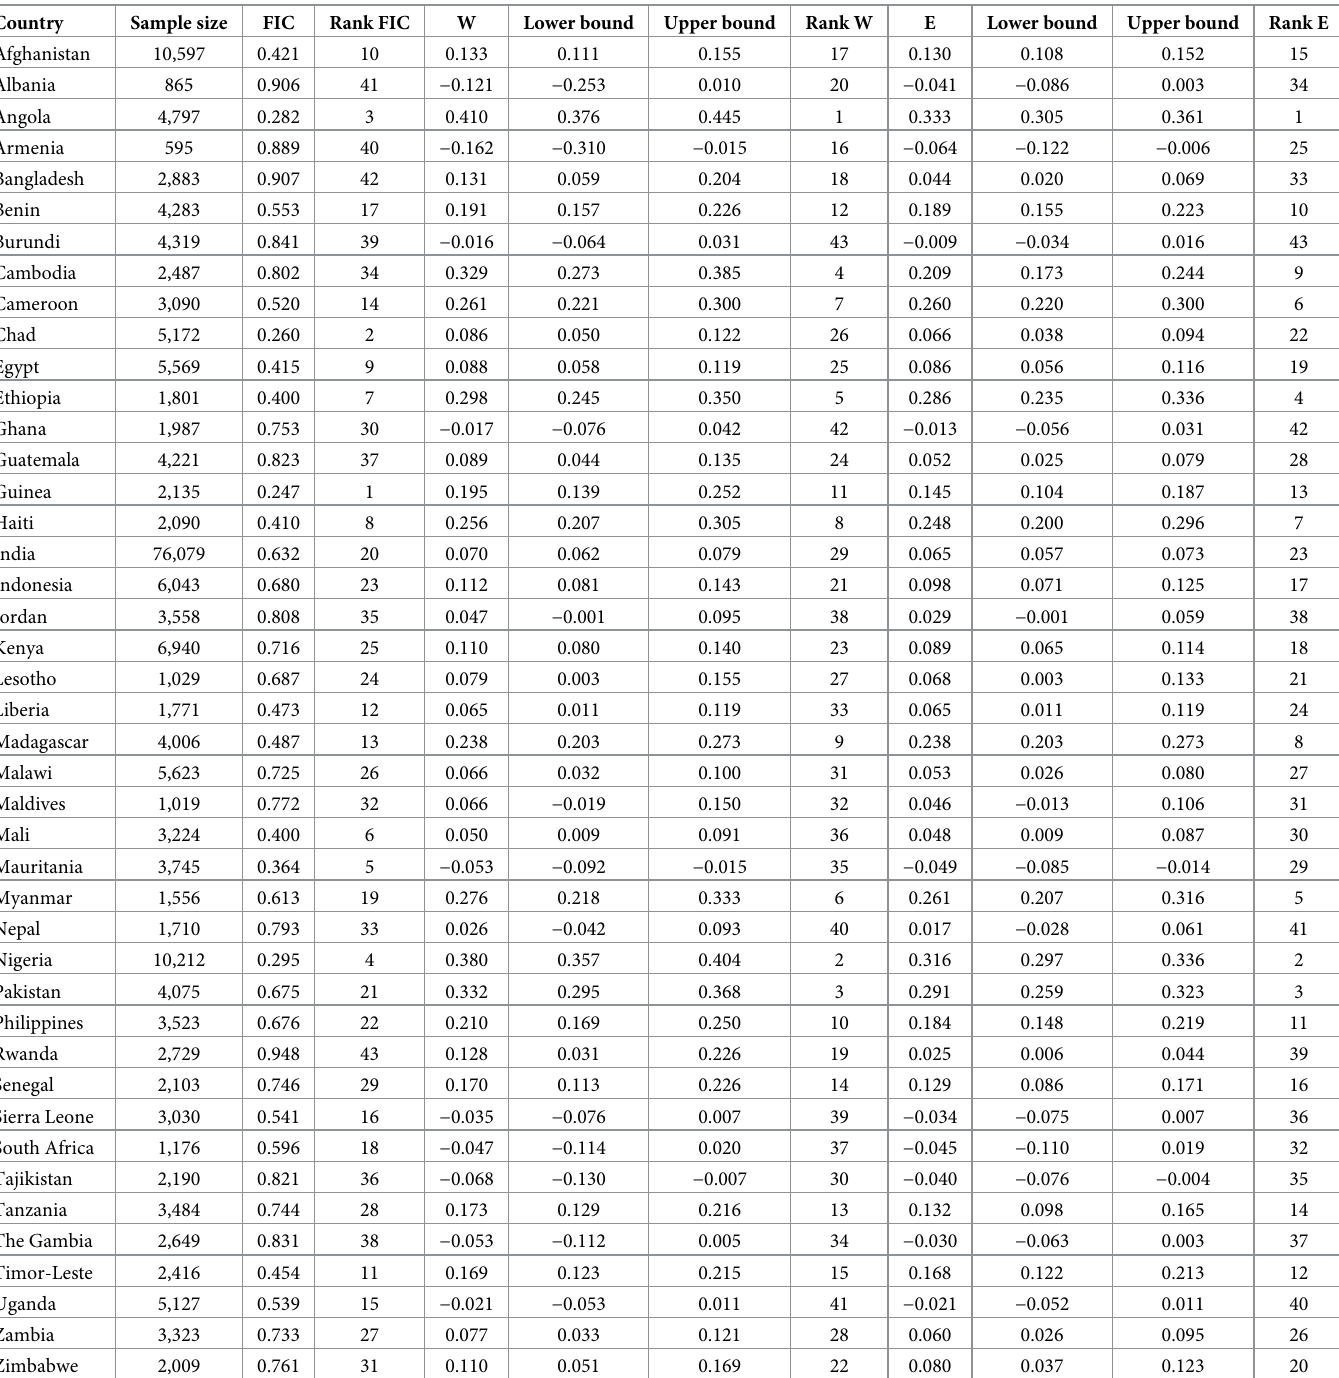
Table 1. National estimates of FIC, Wagstaff’s index of inequality (W), and Erreygers’ index of inequality (E) for 43 countries.